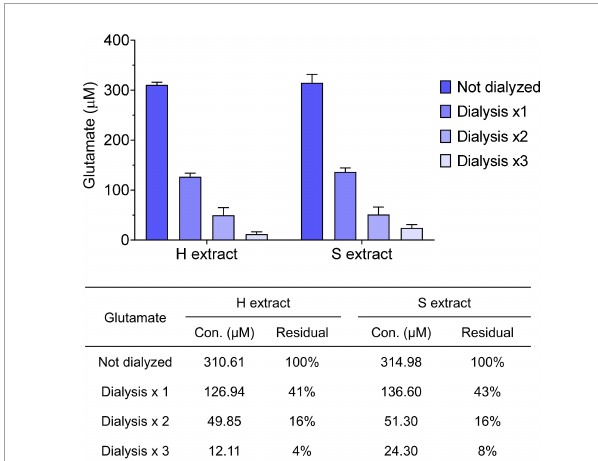
FIGURE2 Small molecules are effectively removed from samples by dialysis. Glutamate concentration in human brain extracts was measured prior to and after each round of dialysis. The table shows the average values measured and the calculated residual percentage. Values were shown as mean ±